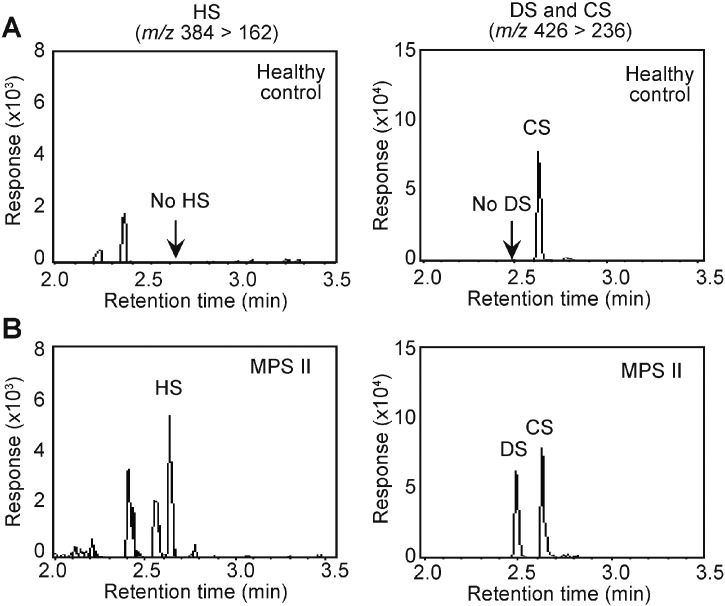
Representative chromatograms of the HS, DS and CS in the urinary GAGs determined using LC-MS/MS. Representative chromatograms of HS (left, m/z 384 > 162) and DS and CS (right, m/z 426 > 236) from a healthy human subject (A) and a 13-year-old MPS-II patient (attenuated type, B) were shown.